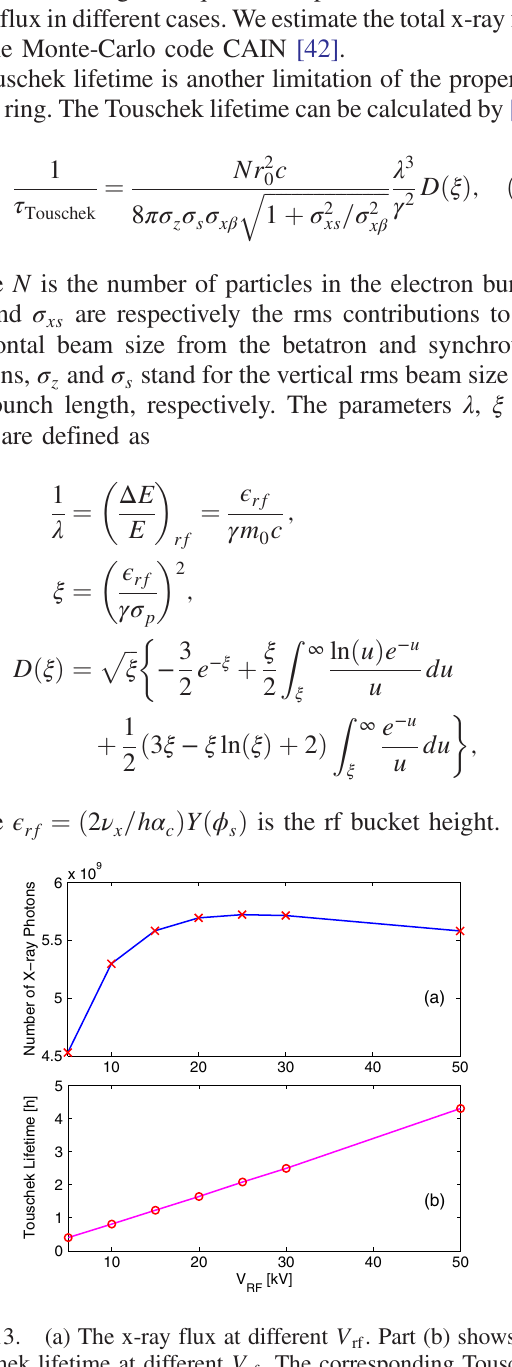
FIG. 13. (a) The x-ray flux at different V Touschek lifetime at different V lifetime is about 2 hours when the maximum x-ray flux (about 5 . 7 × 10 9 photons = s) is achieved.